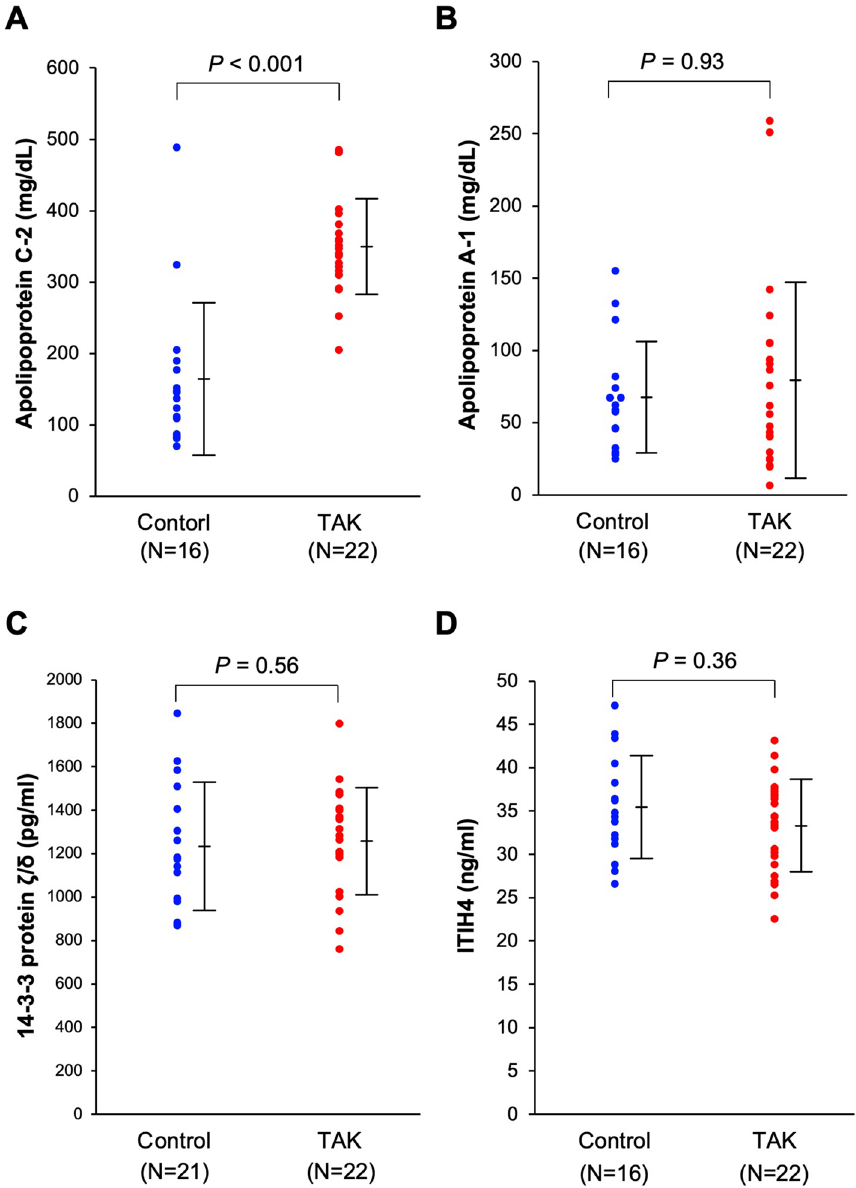
Figure 4. ( A ) The plasma level of apolipoprotein C2 (ApoC-2) is significantly increased in the Takayasu arteritis (TAK) patient group compared with that in the control group (control: N = 16, mean = 82.1 mg/dL; TAK: N = 22, mean = 173.6 mg/dL; P < 0.001). The clinical standard level of ApoC-2 in the plasma is 1.5–3.8 mg/ dL for women. ( B ) The plasma level of apolipoprotein A1 (ApoA-1) shows no significant difference between the TAK patient and control groups (control: N = 16, mean = 67.6 mg/dL; TAK: N = 22, mean = 79.2 mg/dL; P = 0.93). ( C )The plasma level of 14–3–3 protein ζ/δ shows no significant difference between the TAK patient and control groups (control: N = 16, mean = 1233.6 pg/mL; TAK: N = 22, mean = 1259.3 pg/mL; P = 0.53). ( D ) The plasma level of inter-α-trypsin inhibitor heavy chain H4 isoform 1 precursor (ITIH4) shows no significant difference between the TAK patient and control groups (control: N = 16, mean = 35.4 ng/mL; TAK: N = 22, mean = 33.6 ng/ mL; P =